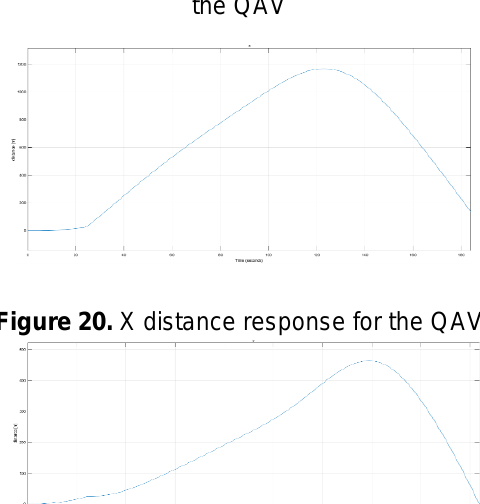
Figure 19. 2D (Y-Z) view of Simulink flight path of the QAV